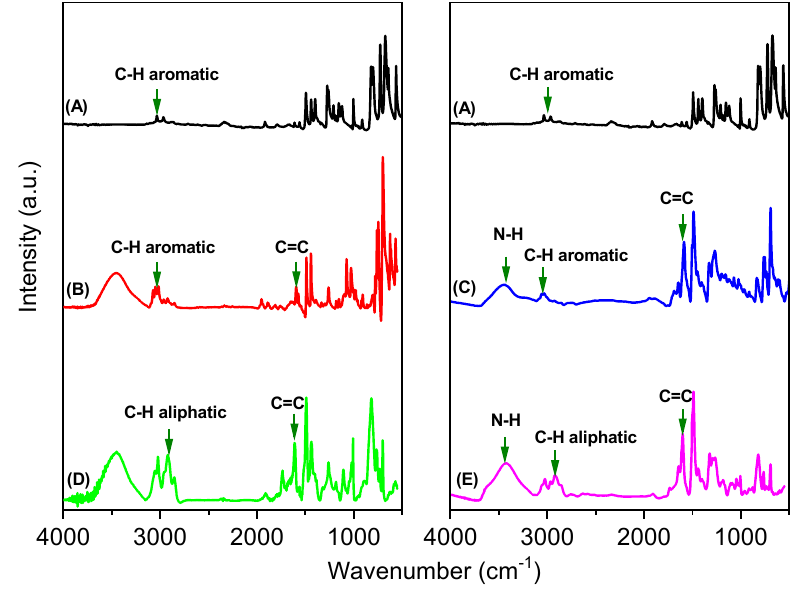
Figure 2. FTIR analyses of ( A ) Ph-2Cl, ( B ) TPE, ( C ) DPT, ( D ) TPE-HPP and ( E ) DPT-HPP.